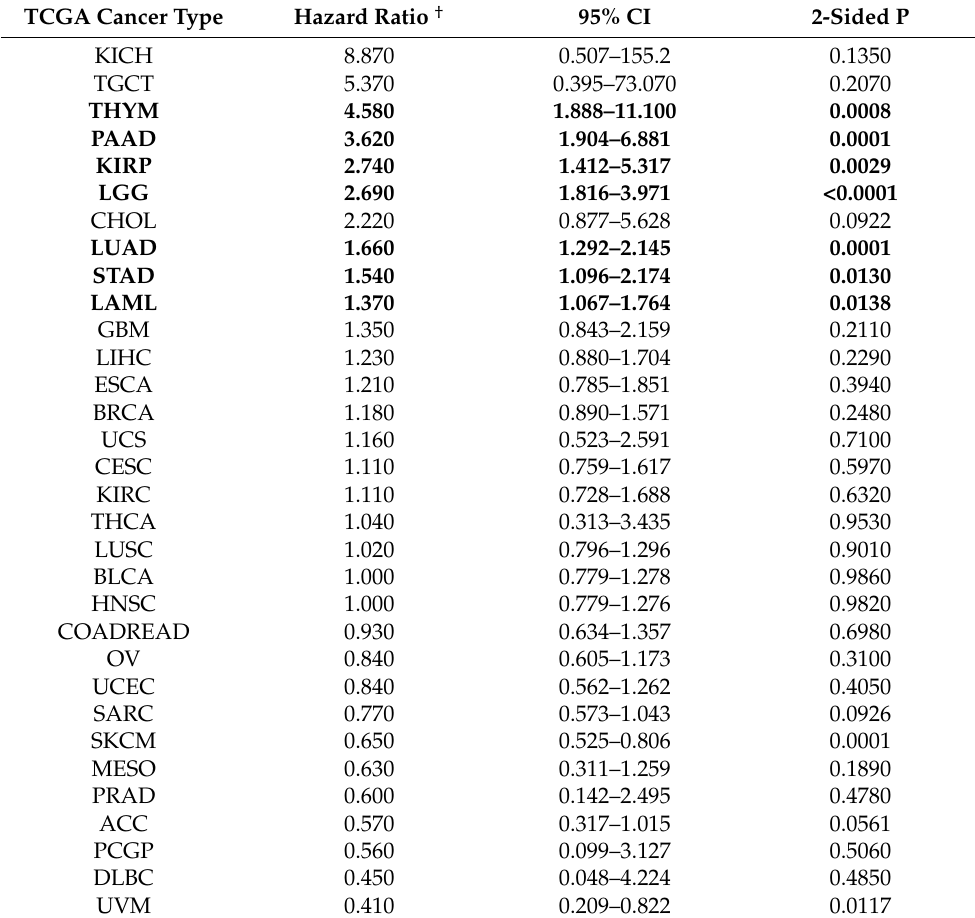
Table A1. Association between tumoral KYNU mRNA expression and overall survival across 32 cancer types in TCGA PanCancer Atlas